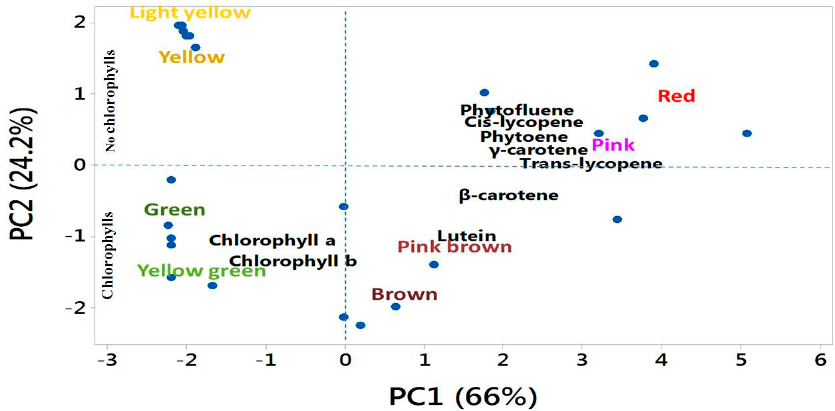
Figure 6. Biplot of biochemical content relevant to the tomato fruit color in the eight different fruit-color